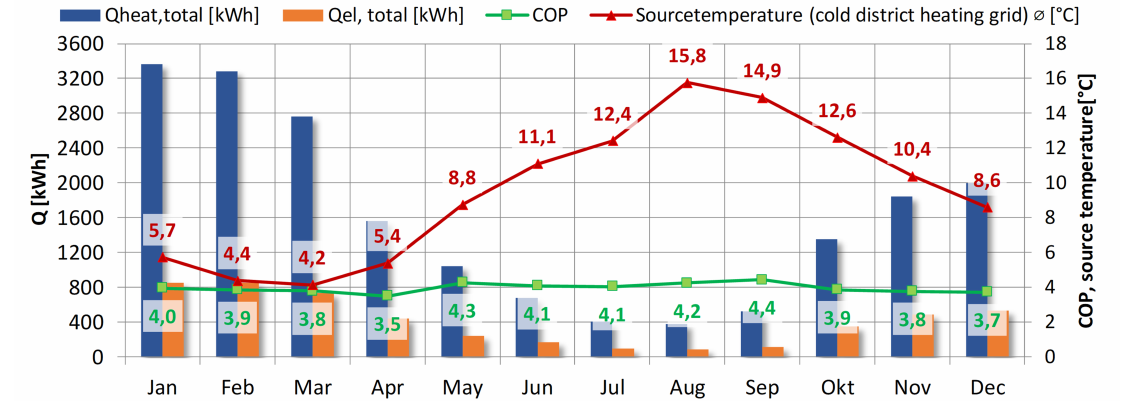
Figure 6. Measured heating demand and heat pump COP on monthly basis (year: